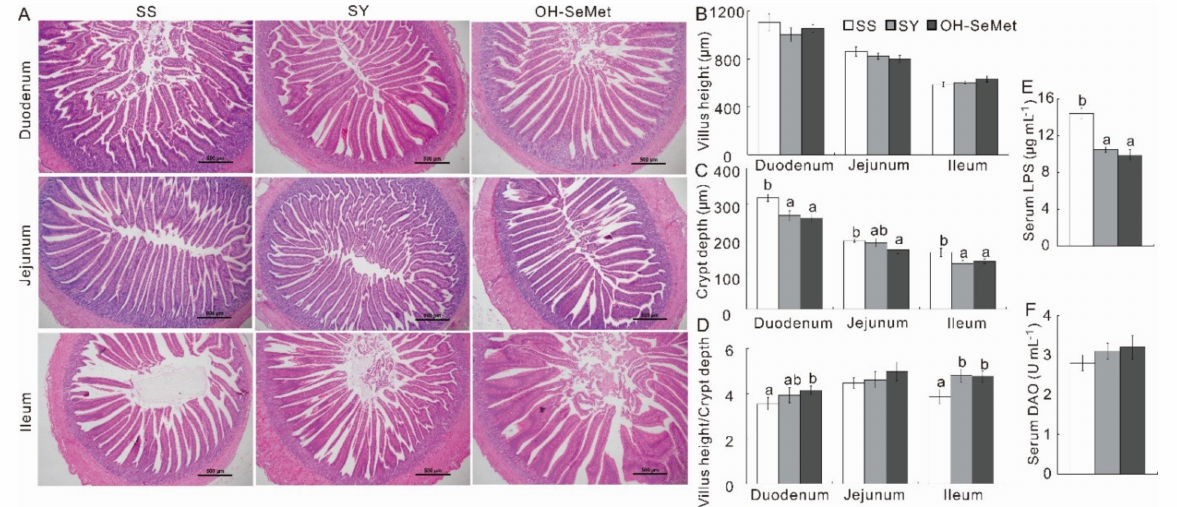
Figure 2. Effect of the three forms of Se on the histology of the intestine ( A ), villus height ( B ), crypt depth ( C ), villus height/ crypt depth ratio ( D ), Serum LPS ( E ) and Serum DAO ( F ) of the chicks. The values are the means ± SE, n = 12. Labeled means within the same plot without a common letter differ, p < 0.05. SS, basal diet supplemented with 0.3 mg Se/kg as sodium selenite; SY, basal diet supplemented with 0.3 mg Se/kg as seleno-yeast; OH-SeMet, basal diet supplemented with 0.3 mg Se/kg as